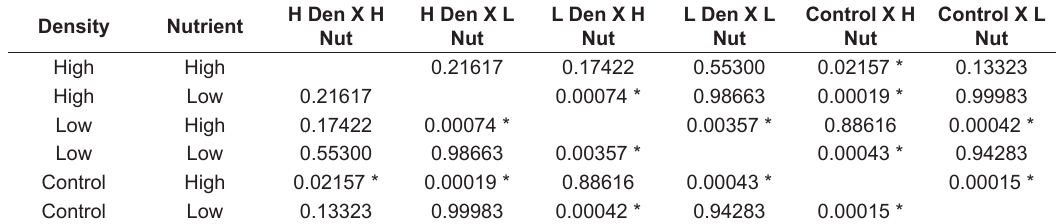
Figure 6. Total biomass of Alternanthera philoxeroides according to the density of neighbor specie (H density or Ldensity), the level of nutrient (Hnutrient or Lnutrient) and the treatment Table 3. Results of Tukey test carried a posteriori of ANOVA two way to verify the difference of density of P. ferrugineum and nutrient on root biomass of A. philoxeroides .